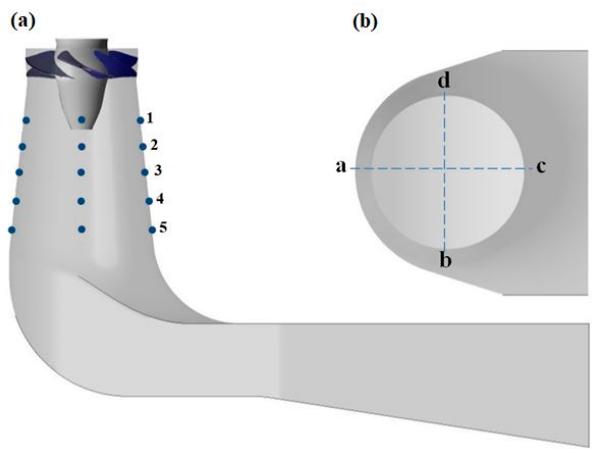
Figure 2. Pressure sensors location on the wall of the draft tube cone. ( a ) The positions are marked by blue dots. ( b ) Circumferential positions.